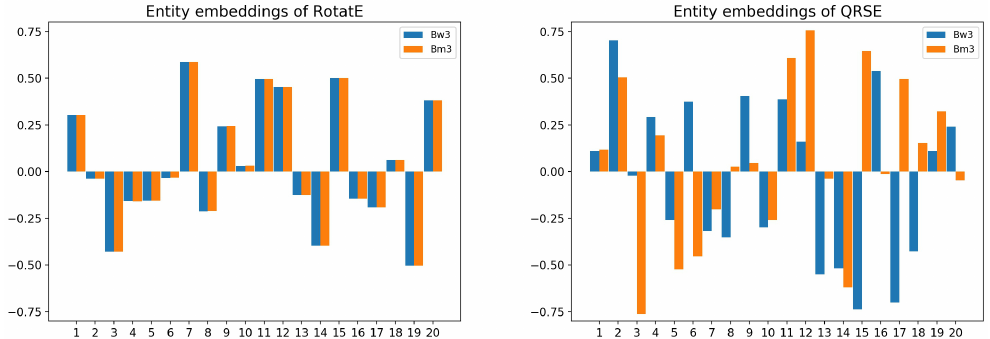
Figure 4. The entity embeddings of RotatE and QRSE on training step 16,000. The 10-D complex or 5-D quaternion vectors are expressed in the corresponding 20-D real vectors.